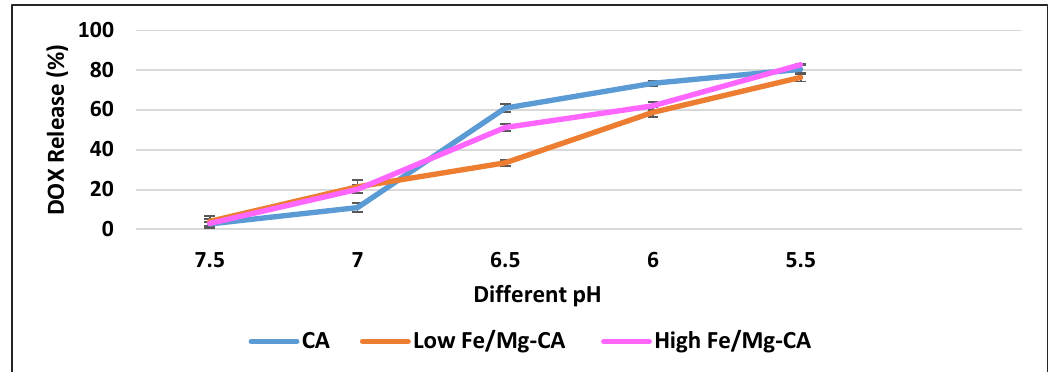
Figure 11. pH dependent release of DOX from CA (20 mM Ca 2+ ), low Fe/Mg-CA (20 mM Ca 2+ , 5 µM